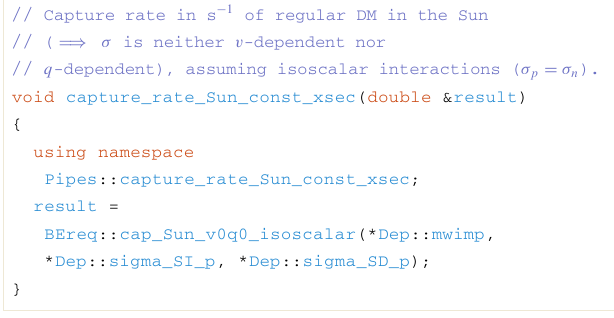
// Capture rate in s − 1 of regular DM in the Sun // q -dependent), assuming isoscalar interactions ( σ